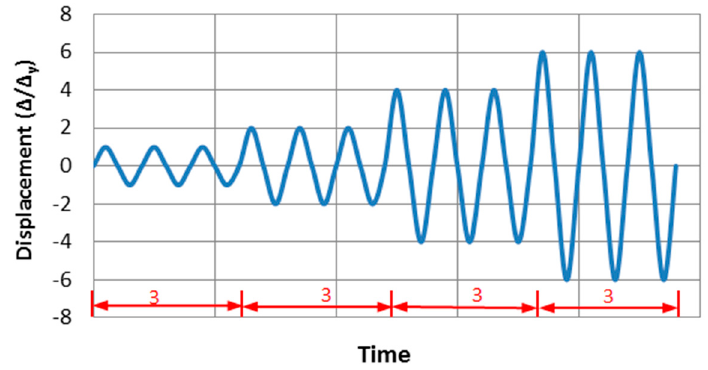
Figure 3. Cyclic loading protocol.